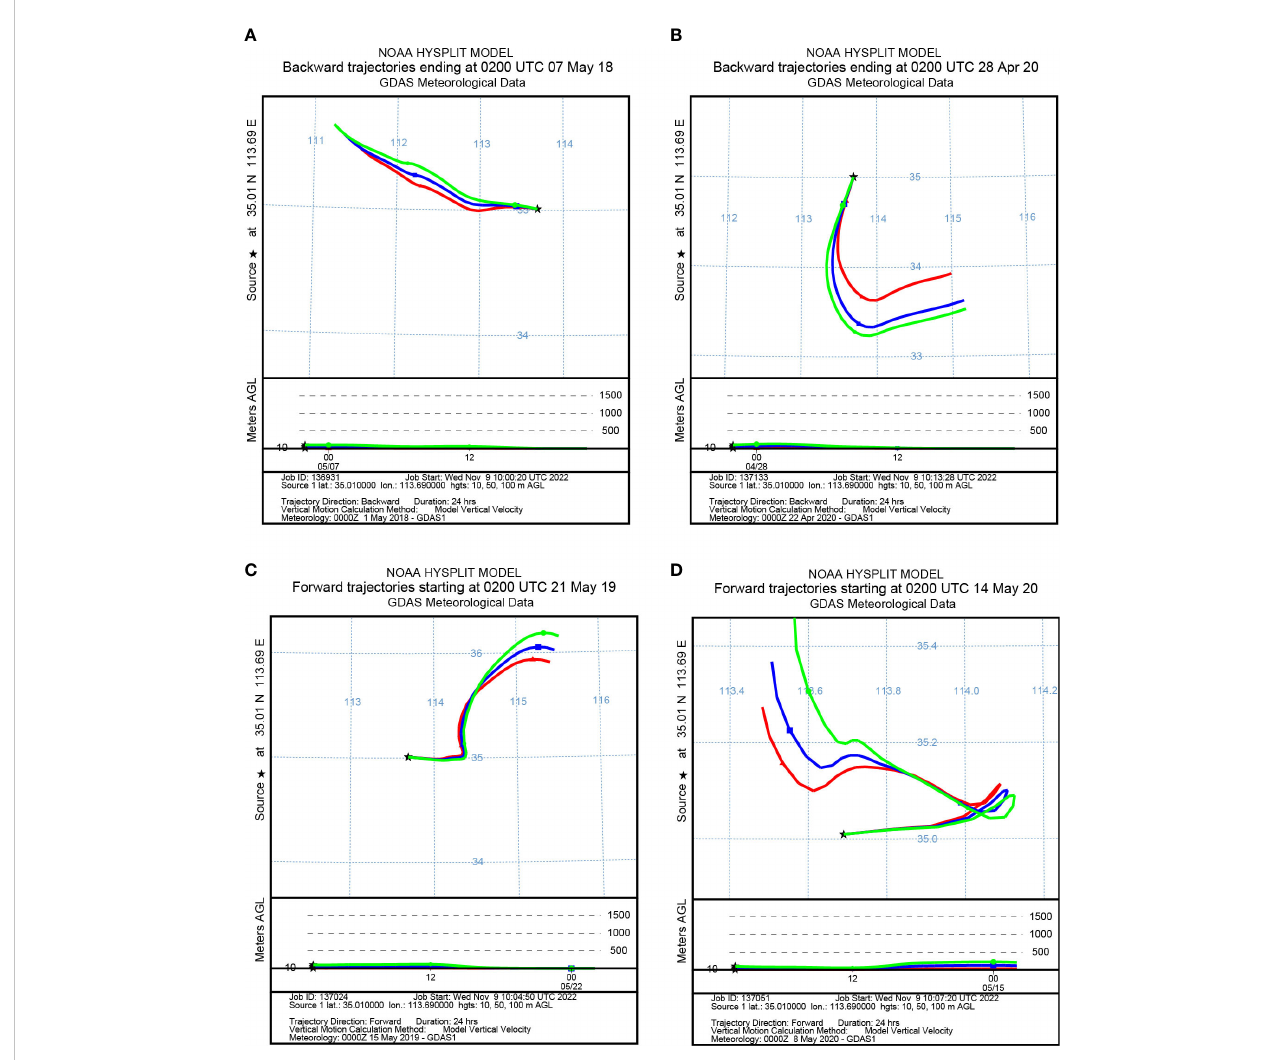
FIGURE 3 The migration trajectories of Sitobion miscanthi simulated by HYSPLIT. (A, B) Simulation of the backward trajectories on 7 May 2018 and 28 April 2020, respectively. (C, D) Simulation of the forward trajectories on 21 May 2019 and 14 May 2020,